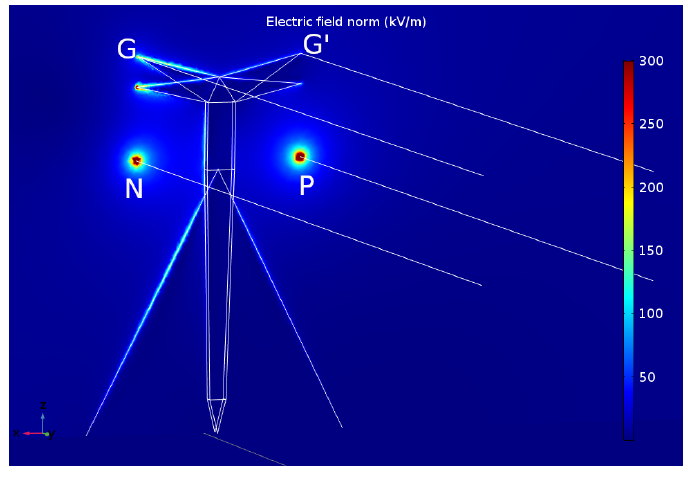
Figure 7. Electric